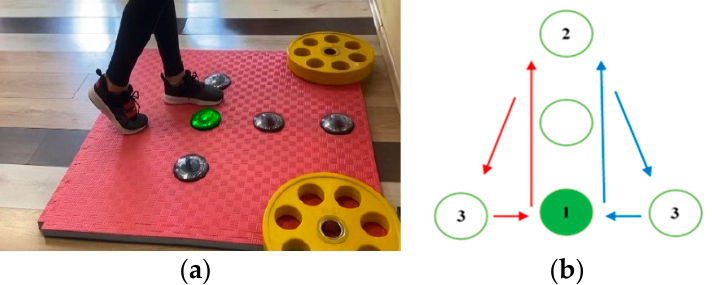
Figure 4. Test 3 (motion following the shape of a lateral triangle): ( a ) starting position for the right leg execution; ( b ) movement pattern.